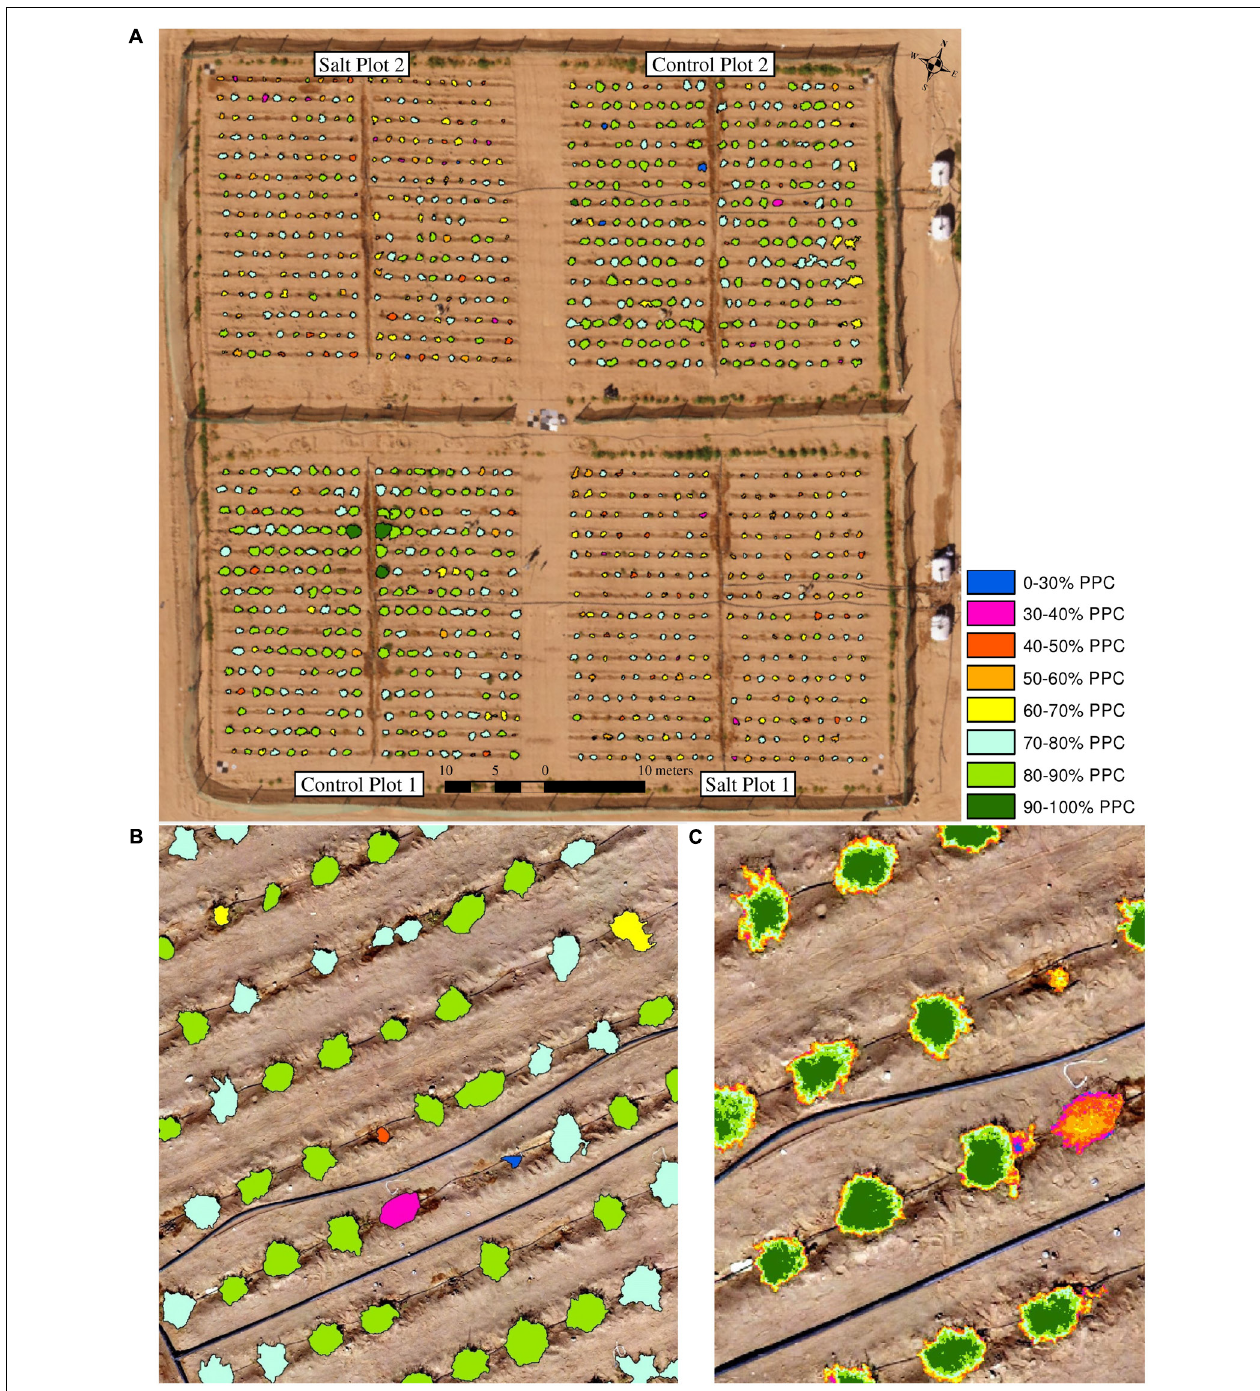
FIGURE 12 | Various reporting scales of PPC based on the RGB imagery collected on January 14, 2018, showing (A) PPC for all four plots, (B) average PPC of individual plants for an image subset and (C) sub-plant PPC distribution of individual plants for an image subset.